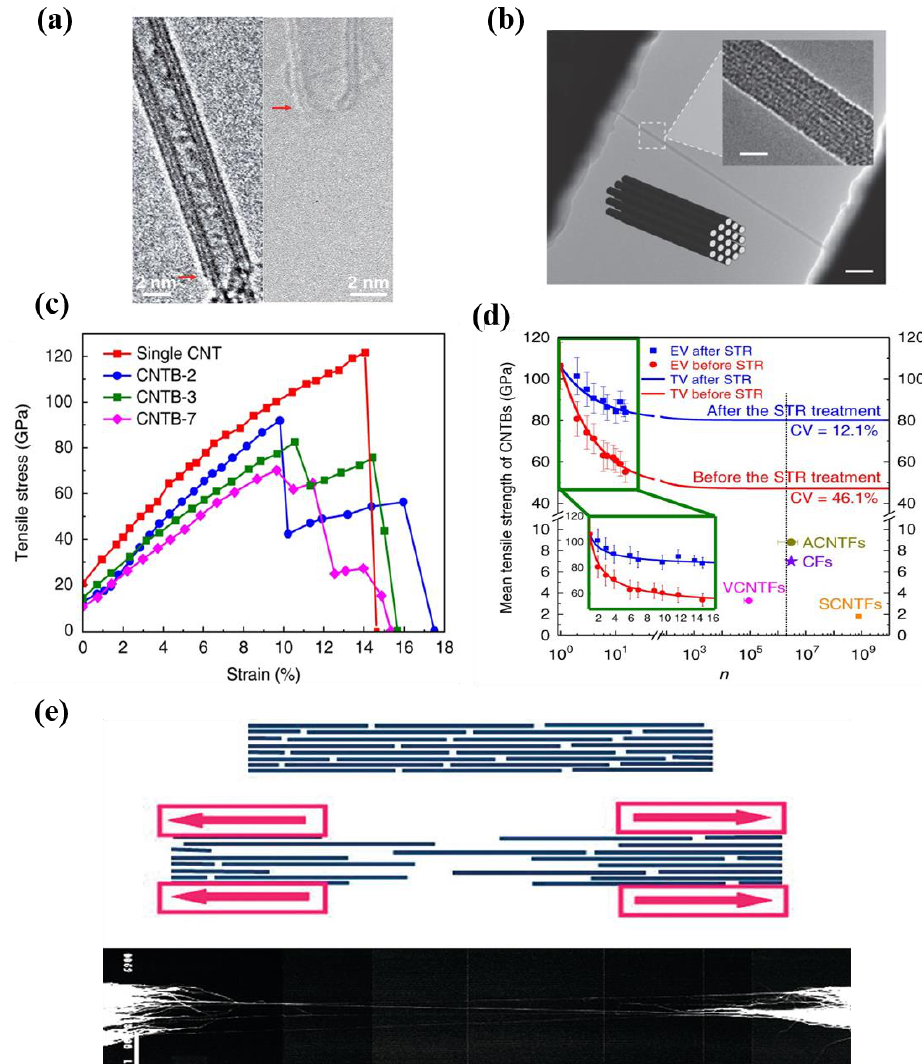
Figure 5. ( a ) TEM images of the flat fracture surfaces (marked by arrows) of the CNTs. Left: static tensile fracture surface; right: fracture surface after cyclic loading. Reproduced with permission from [15]. Copyright 2020, Amer Assoc Advancement Science. ( b ) TEM top view images of a DWCNT bundle (Scale bar: 200 nm). Insert: High-resolution TEM image of the suspended DWCNT